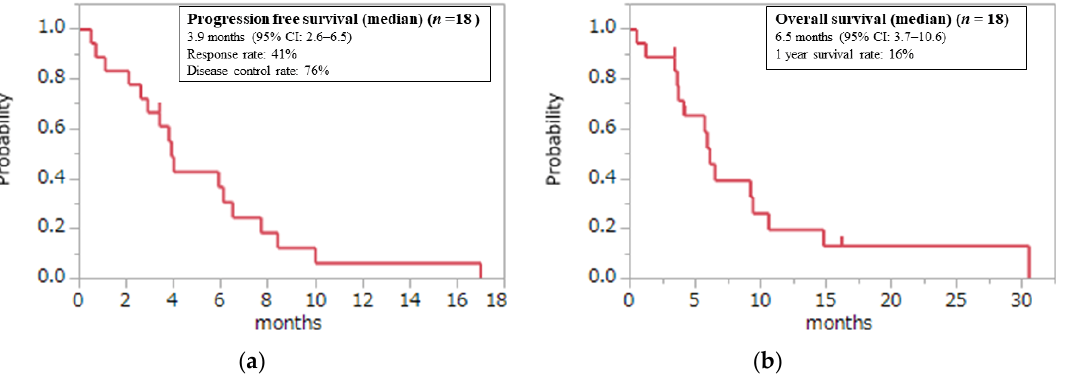
Figure 1. ( a ) Progression-free survival (PFS) and ( b ) overall survival (OS) among all study popula-